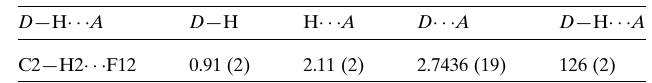
Table 1 Hydrogen-bond geometry (A˚ , (cid:3) ).